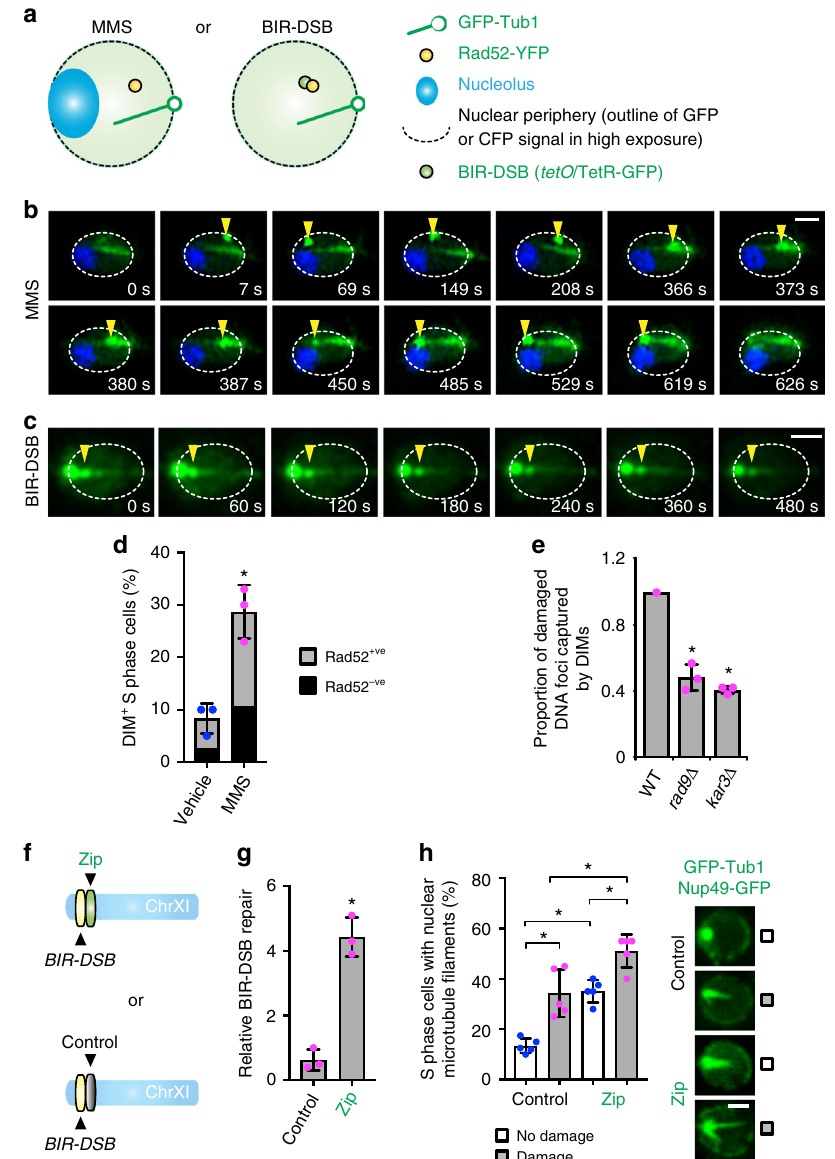
Fig. 2 DIMs capture/mobilize damaged DNA and promote DNA repair. a Systems used to visualize damaged DNA in live wild-type cells. b , c Time-lapse super-resolution microscopy showing the dynamics of Rad52-marked damaged DNA (yellow arrowhead) relative to DIMs. Scale bar, 1 µ m. d Quanti fi cation of the proportion of DIM-positive S-phase cells with and without Rad52 foci. Mean± s.d.; N = 3. * P = 0.0039, two-tailed unpaired t test. e Relative effect of rad9 Δ or kar3 Δ on the ability of DIMs to capture damaged DNA. Relative mean ± s.d.; N = 3. * P ≤ 0.0011, two-tailed unpaired t test. f Zip or control DNA sequence integration near the BIR-DSB site. g Effect of the zip code on BIR-DSB repair. Mean± s.d.; N = 3. * P = 0.0007, two-tailed unpaired t test. h Quanti fi cation and representative images from confocal microscopy showing the effect of the zip code on DIM levels in the absence or presence of BIR- DSB induction. Mean± s.d.; N = 5. * P ≤ 0.0067, two-way ANOVA Sidak ’ s multiple comparison test. Scale bar, 1 µ m. Individual data points of undamaged (blue) and damaged (magenta) cells are shown